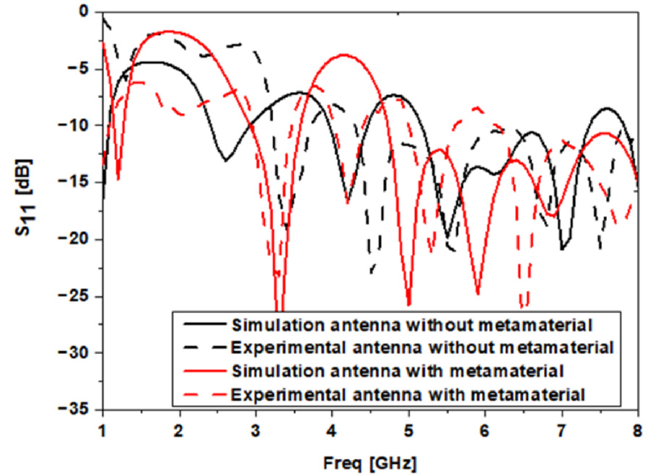
Figure 9. Comparative study of S parameter results of the AVA with and without the metamate- rial.